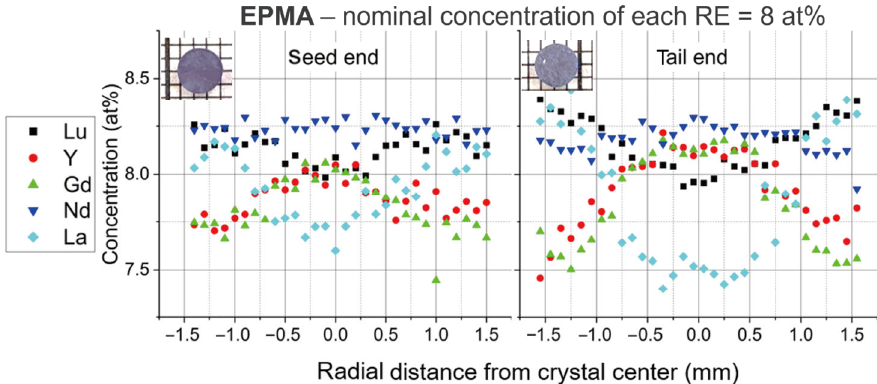
Fig. 9 EPMA radial concentration profiles of seed end (left) and tail end (right) of crystal 3. The legend on the left applies to both graphs. On the vertical axis, − 1.5 and 1.5 mm correspond to the last measurement toward the outer surface of the crystal; zero corresponds to the center of the